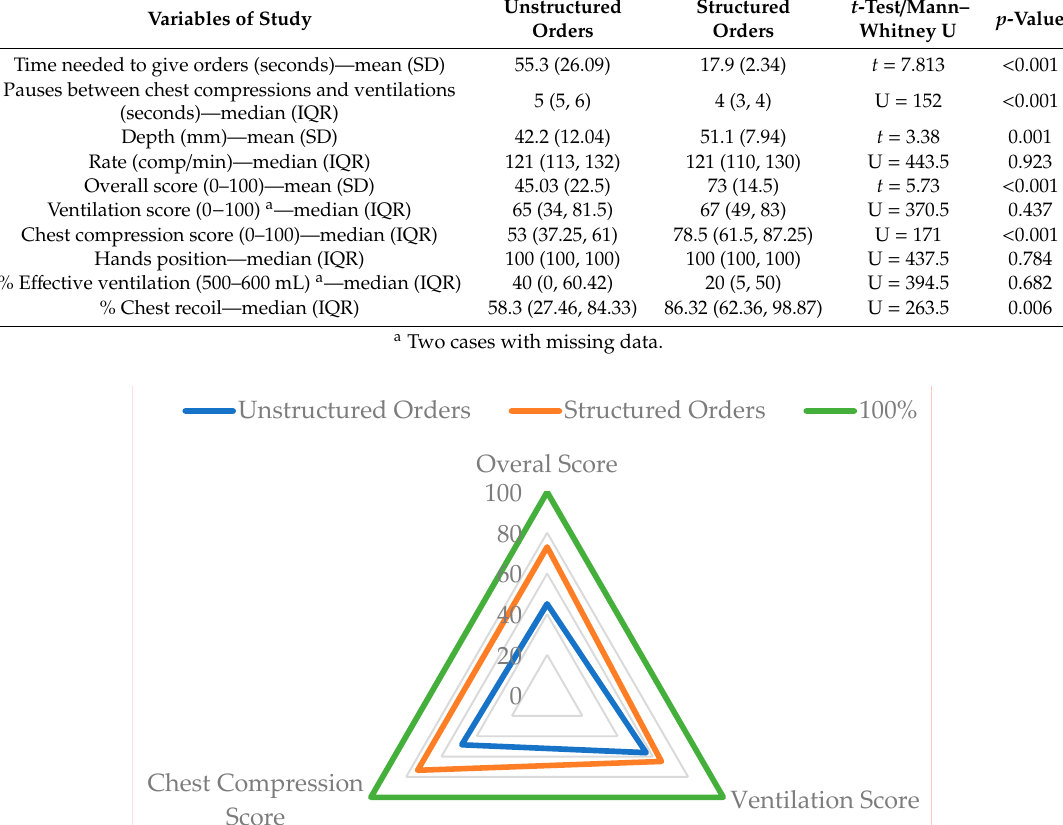
Figure 3. Comparison of the scores reached by each group, with respect to the maximum score.